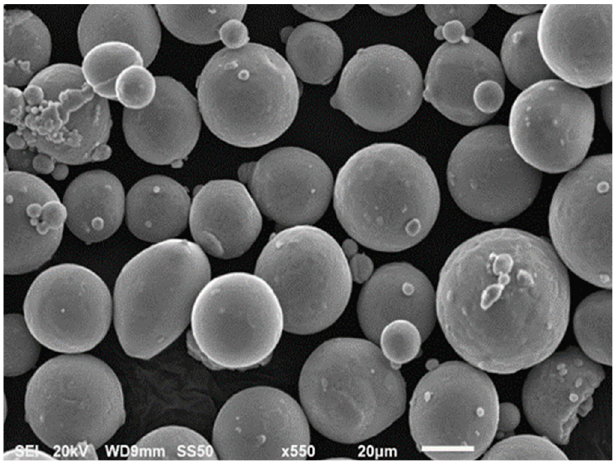
Figure 1. SEM image of the pre-alloyed Ti6Al4V Powder.